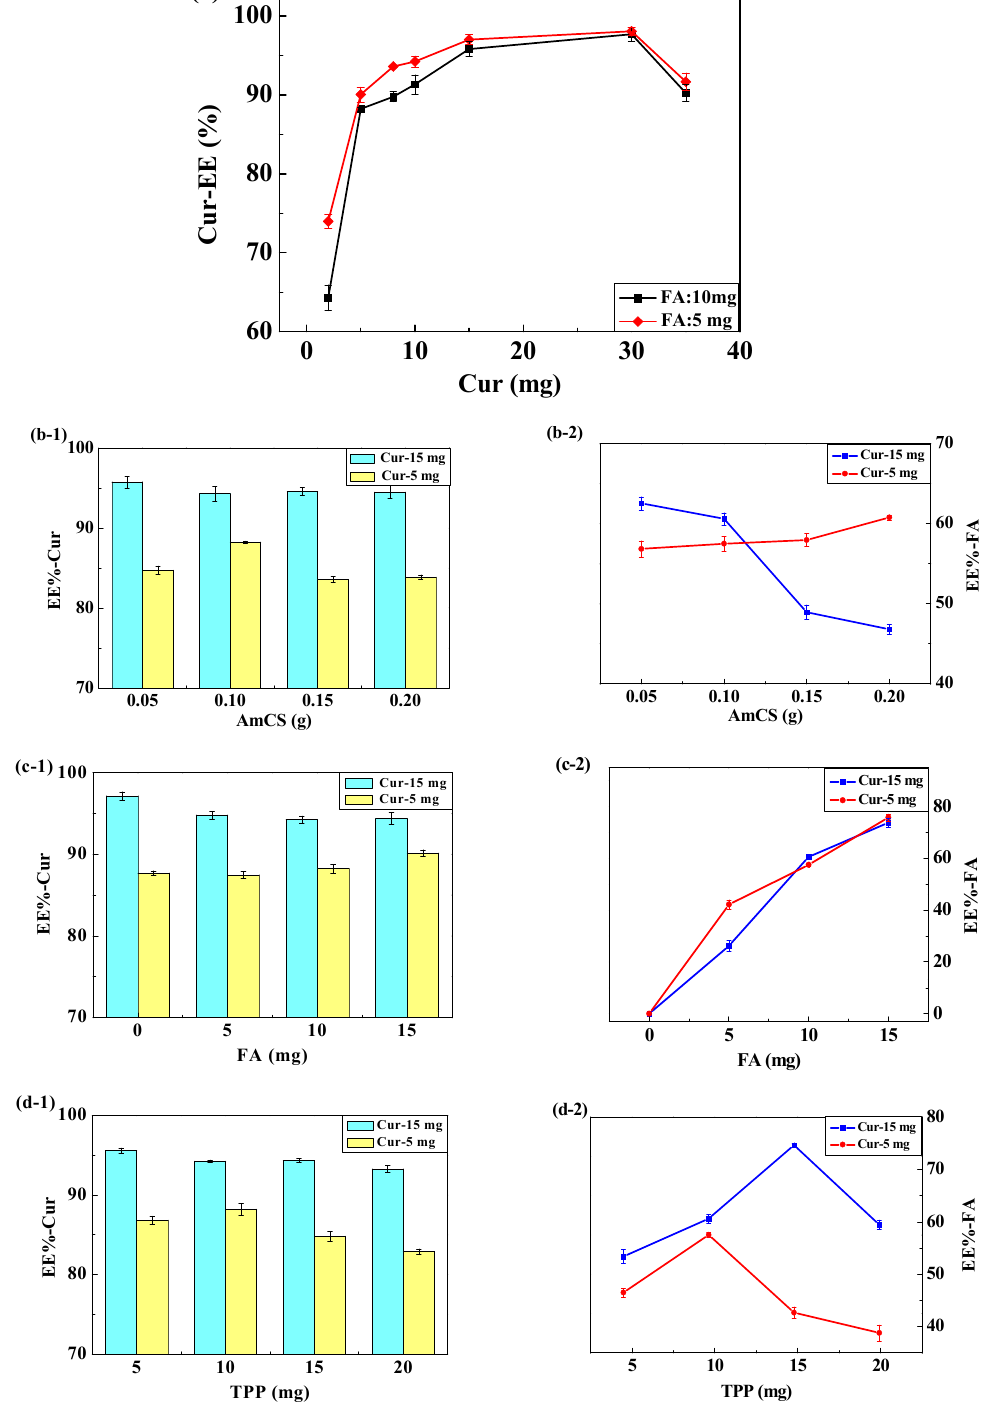
Figure 6. Effect of Cur dosage ( a ), AmCS dosage ( b ), FA dosage ( c ), and TPP dosage ( d ) on the EE-Cur (bar graph) and EE-FA (line graph) of FA-AmCS-TPP nanoparticles. Symbols: Cur 15.0 mg ( ■ ); Cur 5.0 mg ( ● ).